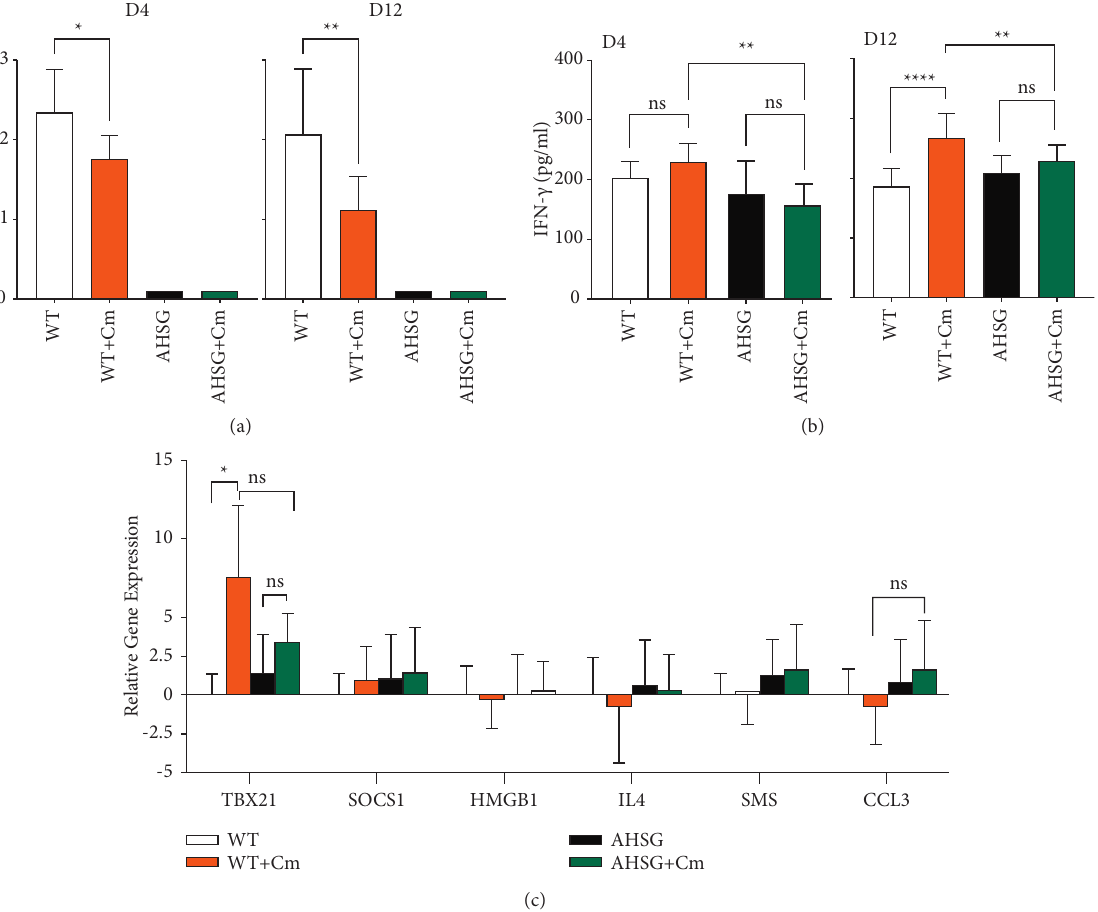
Figure 2: Fetuin-A content is reduced following intranasal Chlamydia challenge and is associated with increased IFN- c content in the lung. Age-matched wild-type (WT) C57BL/6 and fetuin-A-deficient AHSG mice were challenged intranasally with 500 IFU Cm. Lung tissue (days 4 and 12) was collected and homogenized as described under “Materials and Methods.” (a) Fetuin-A content. (b) IFN- c content. (c) Relative expression (fold-change) of TBX21, SOCS1, HMGB1, IL-4, SMS, and CCL3 genes. Determination of fetuin-A and IFN- c content and real- time quantitative reverse transcription analysis were carried out as described under “Materials and Methods.” Respective bars represent the mean ± SD. Differences between indicated groups were analysed by one-way ANOVA with Tukey’s multiple comparison test. ∗ P < 0 . 05, ∗∗ p < 0 . 01, ∗∗∗ p < 0 . 001, and ∗∗∗∗ p < 0 .